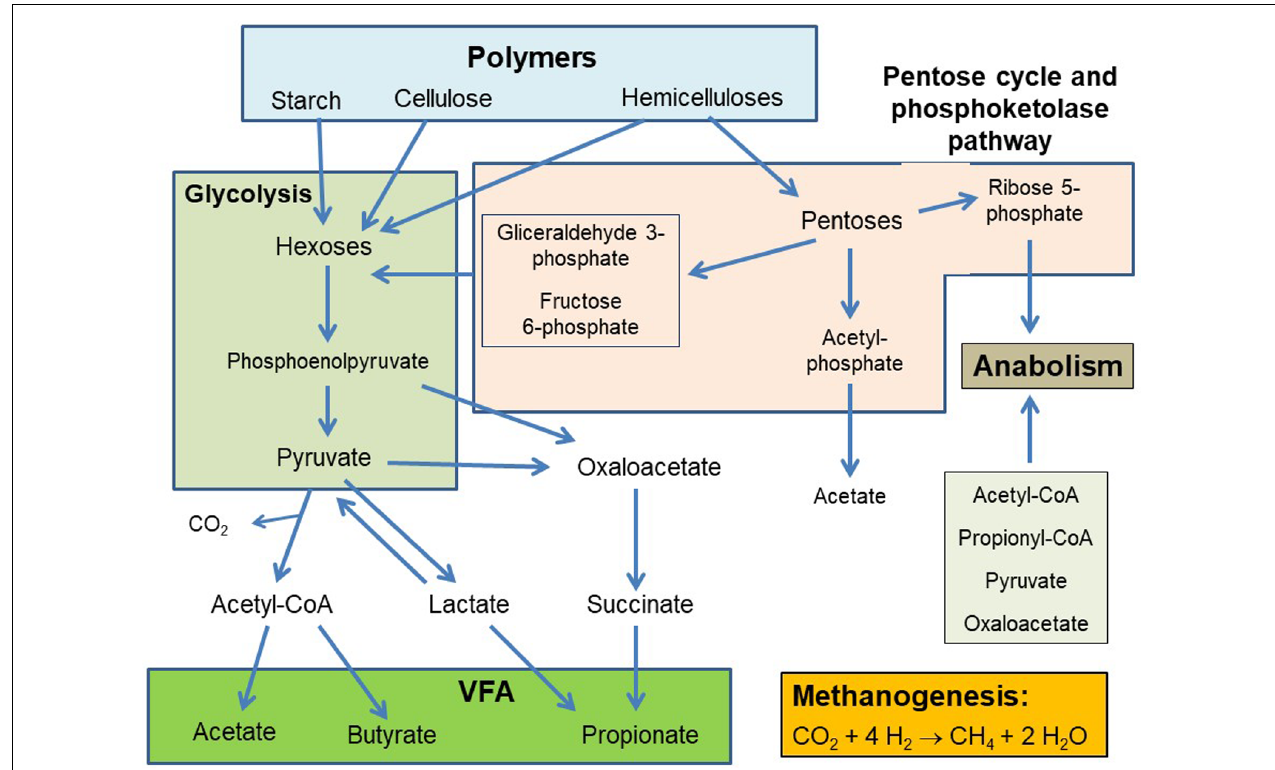
FIGURE 1 | Simplified scheme of carbohydrates fermentation in the rumen.